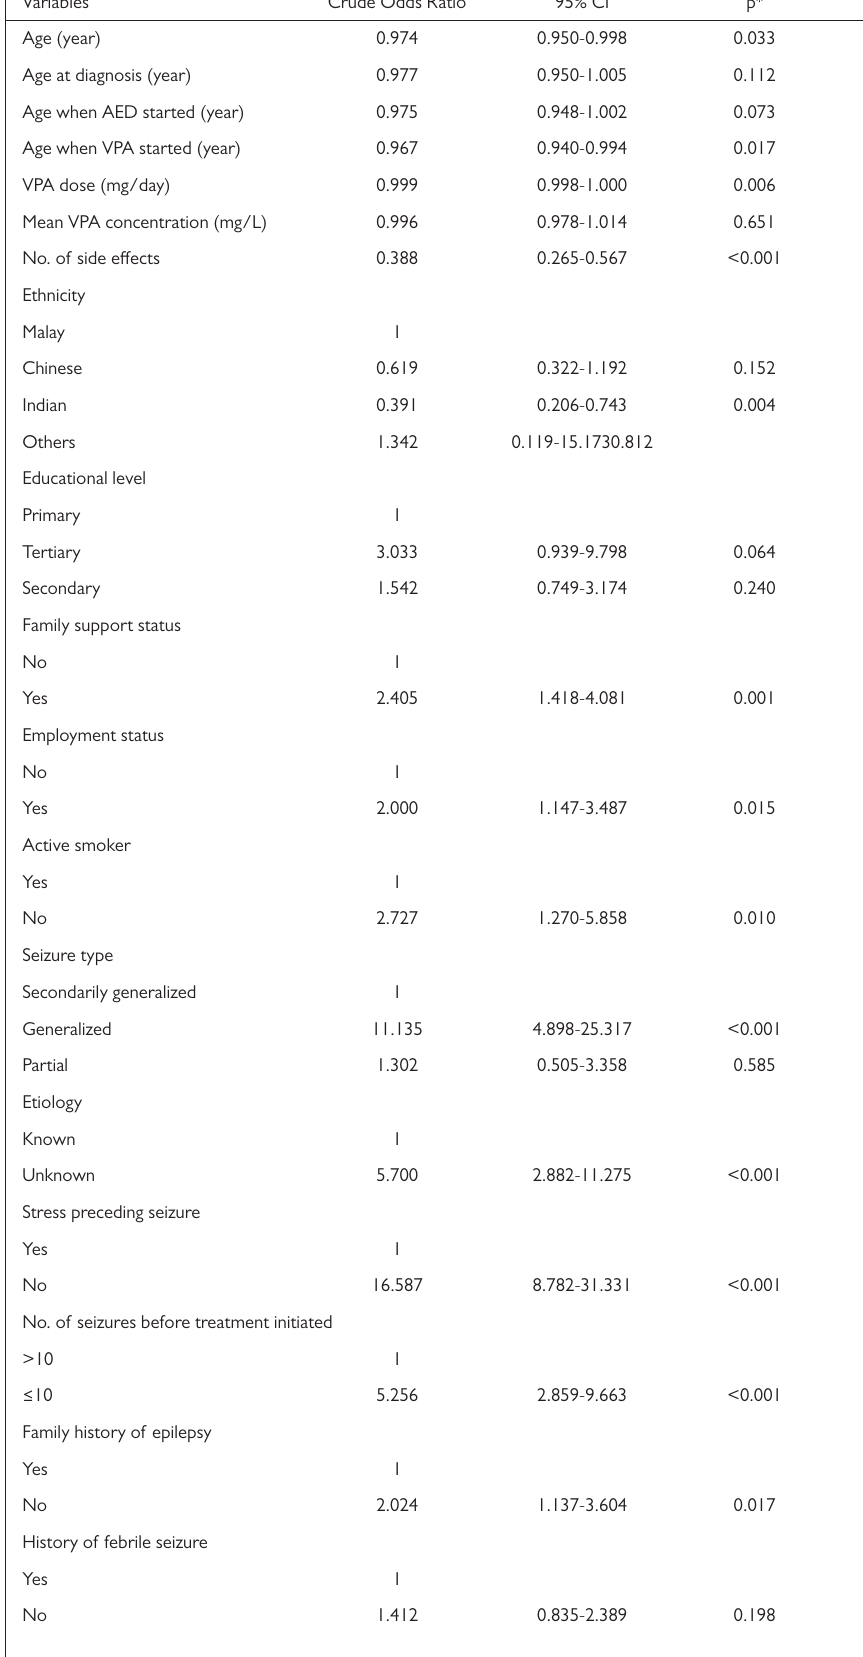
Table 2. Univariate analysis of predicting factors for good seizure control (n=242)